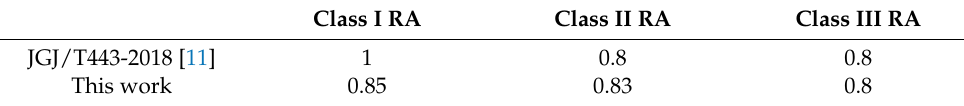
Table 7. Values of η in JGJ/T443-2018 and this work when r =